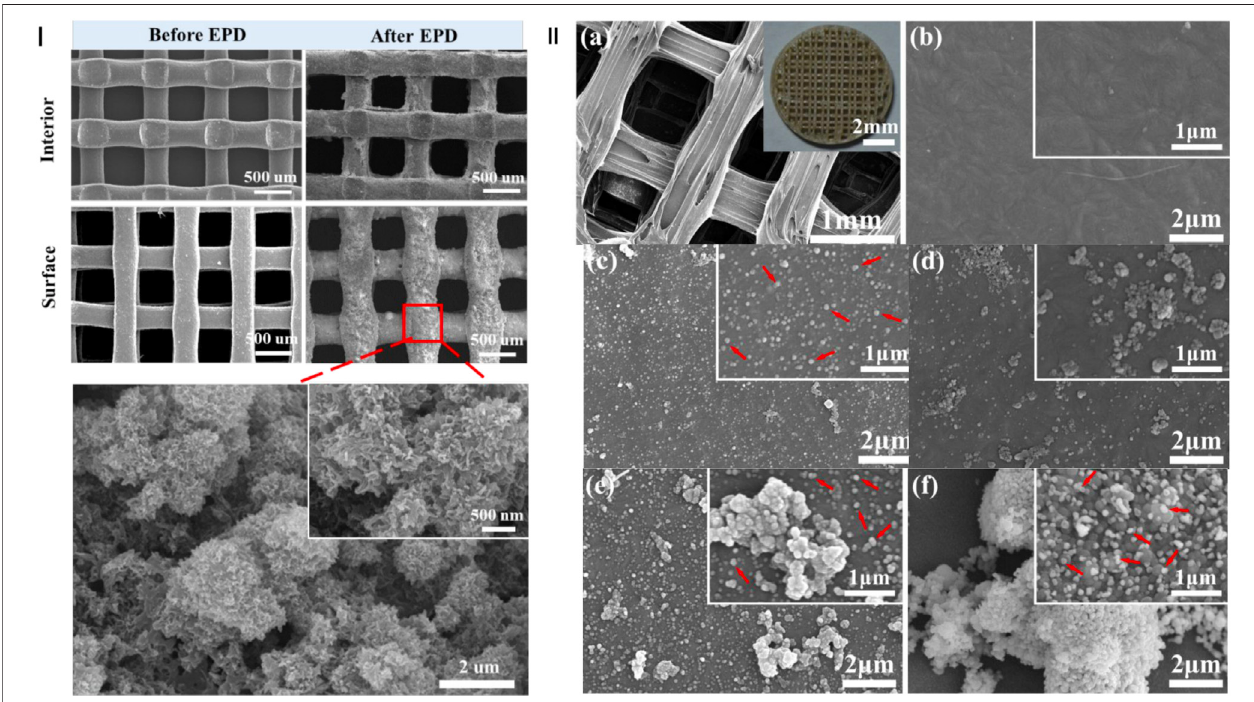
FIGURE 5 | Modi fi cation of 3D-printed PEEK. (I) SEM images of the 3D-printed PEEK/graphene composite scaffold before and after drug-laden hydroxyapatite- coatingdeposition.AdaptedwithpermissionfromZhuetal(2021).Copyright(2021)AmericanChemicalSociety. (II) SEMoverviewofthe3D-printedPEEKscaffolds. (A) SEM zoom images, (B) 3D-printed PEEK, (C) AgNP-decorated PEEK, (D) apatite-decorated PEEK, (E) “ PDA – Ag – PDA – apatite ” multilayers on PEEK, and (F) “ PDA – apatite – PDA – Ag ” multilayers on PEEK. Red arrows point to AgNPs. Adapted with permission from Deng et al (2020). Copyright (2020) American Chemical